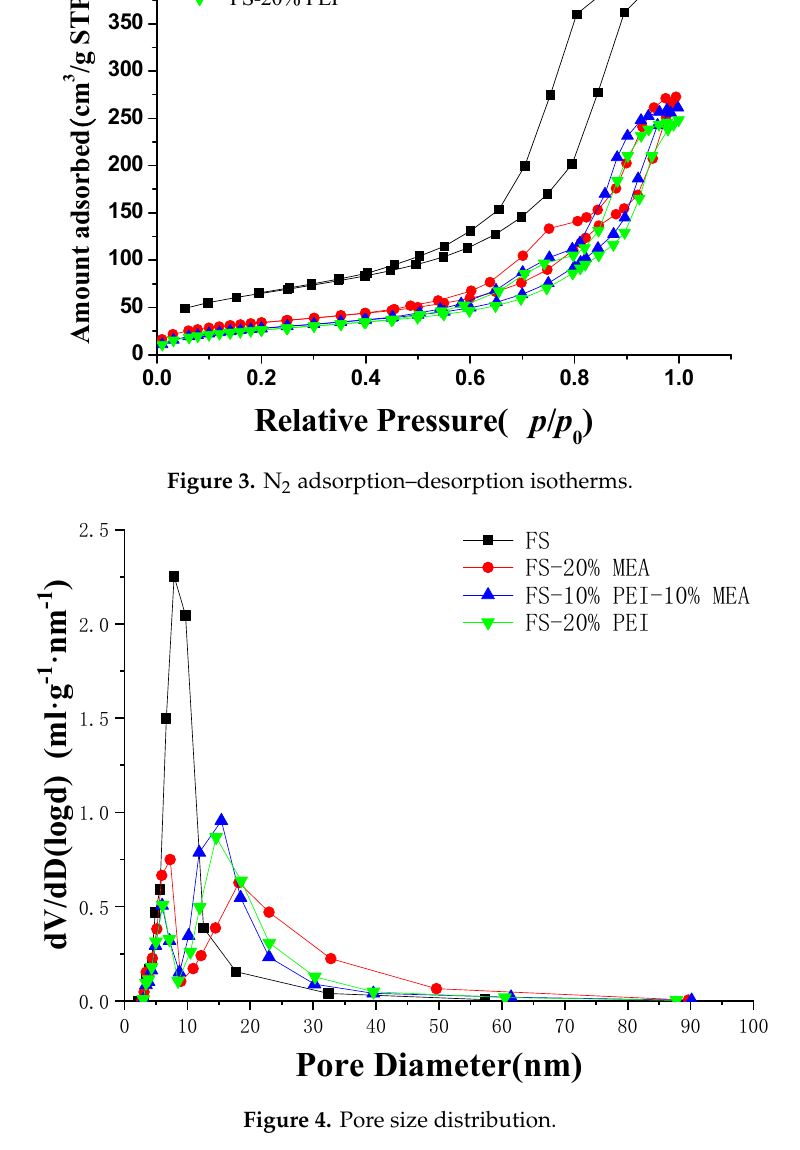
Table 1. Textural properties of the silica before and after impregnating organic amine.